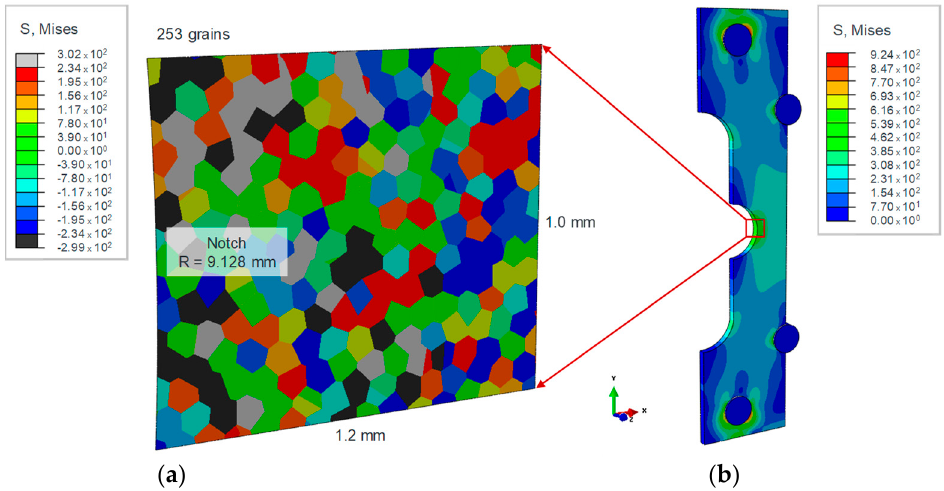
Figure 8. ( a ) Shear stresses in a 3D deformable shell submodel of the AISI 1141 steel; ( b ) 3D global model of the notched tensile specimen (half), reproduced from [52], with permission from Elsevier, 2018. Table 3. CRSS values for different